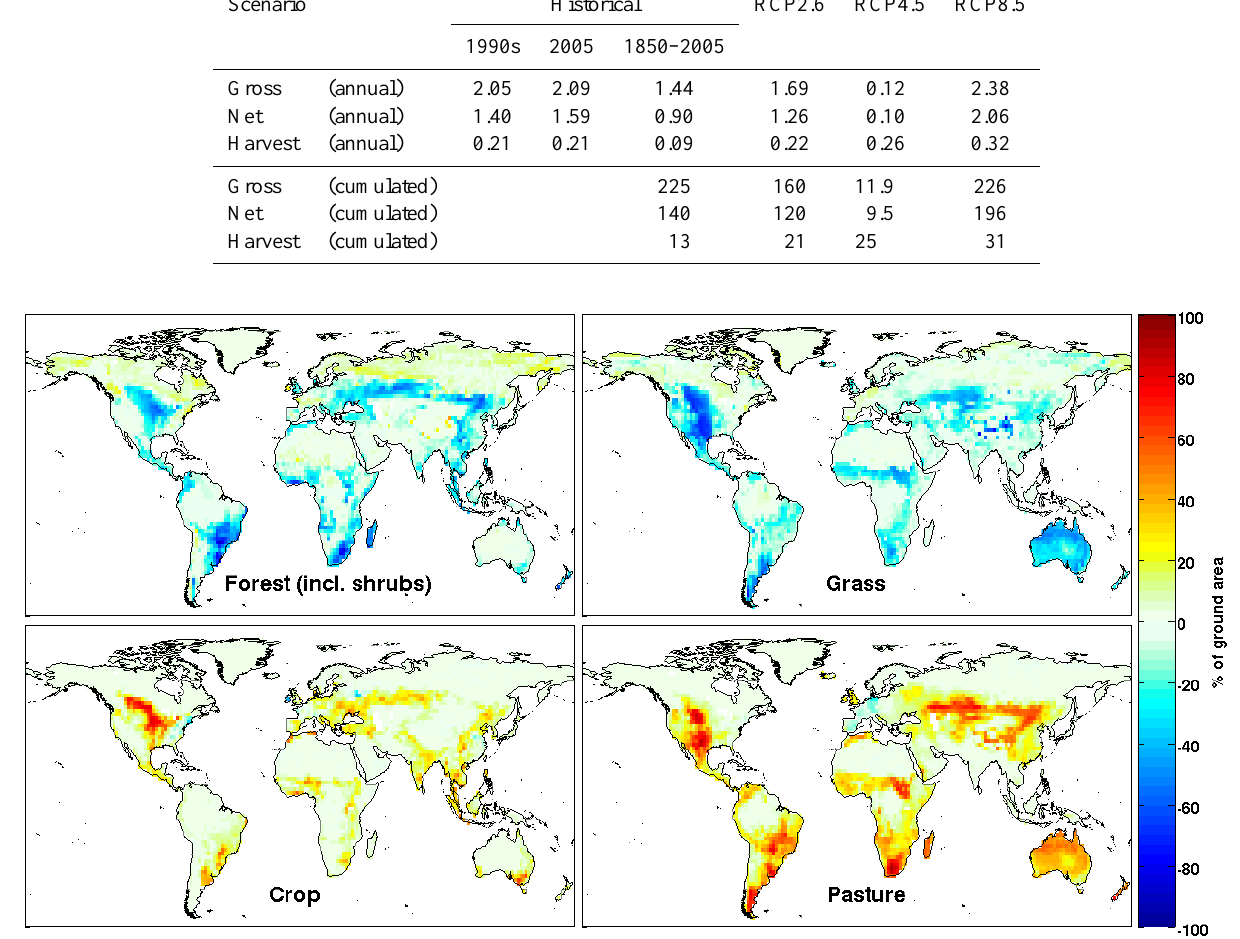
Figure 2. Modelled change in area of different vegetation types during the historical period (1850–2005). 1.4 Pg C yr − 1 in the early 1980s with a peak in the